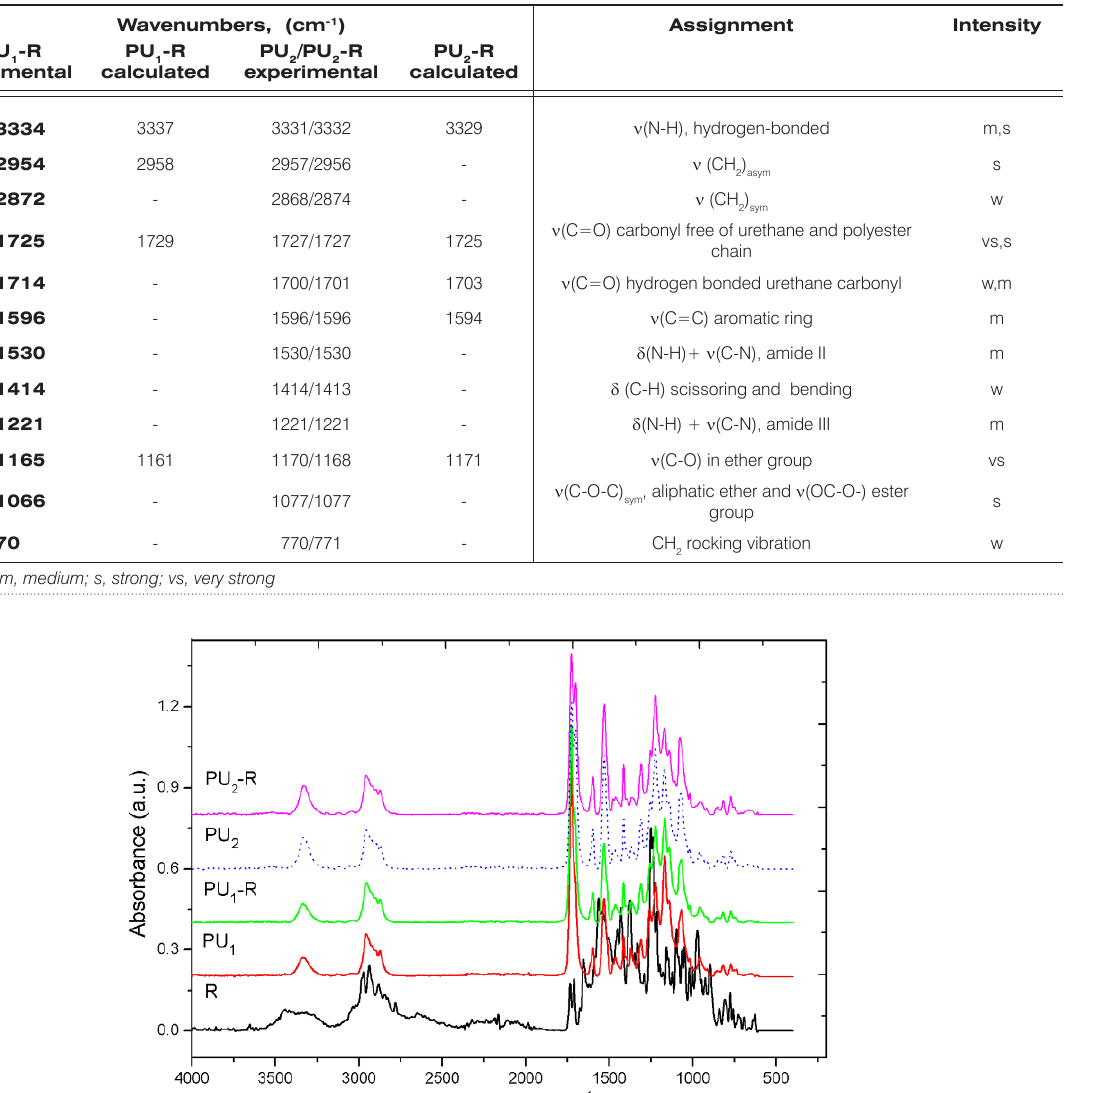
Table 1. The polyurethanes and polyurethanes with Rifampicin.